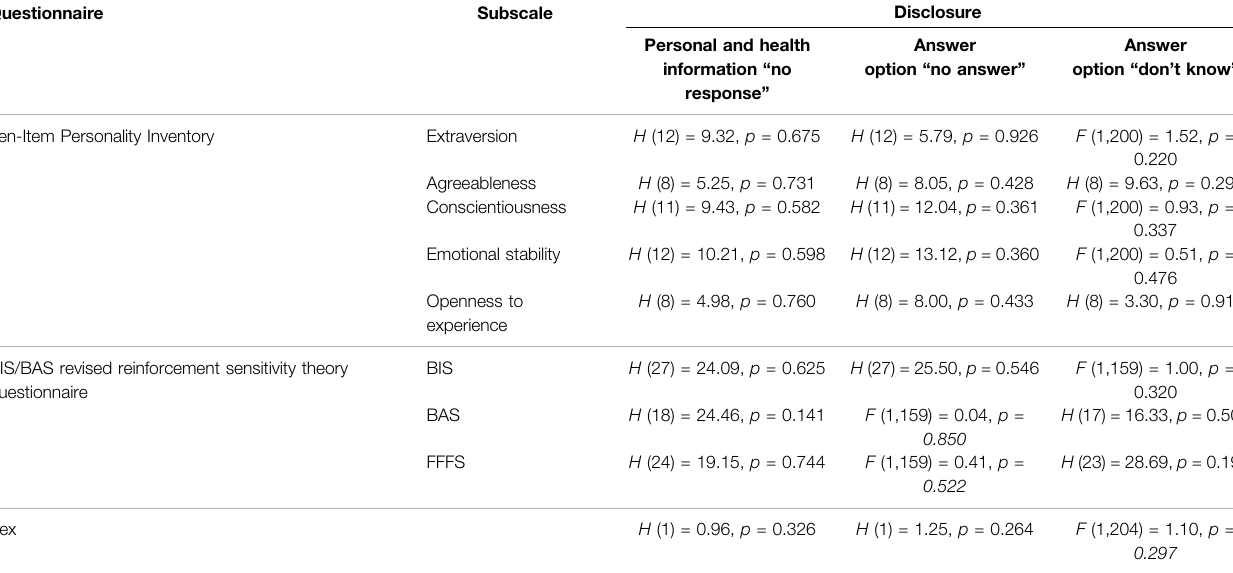
TABLE 5 | Regression of personality and gender on disclosure of personal and health information and general disclosure over all items. DisclosureQuestionnaire